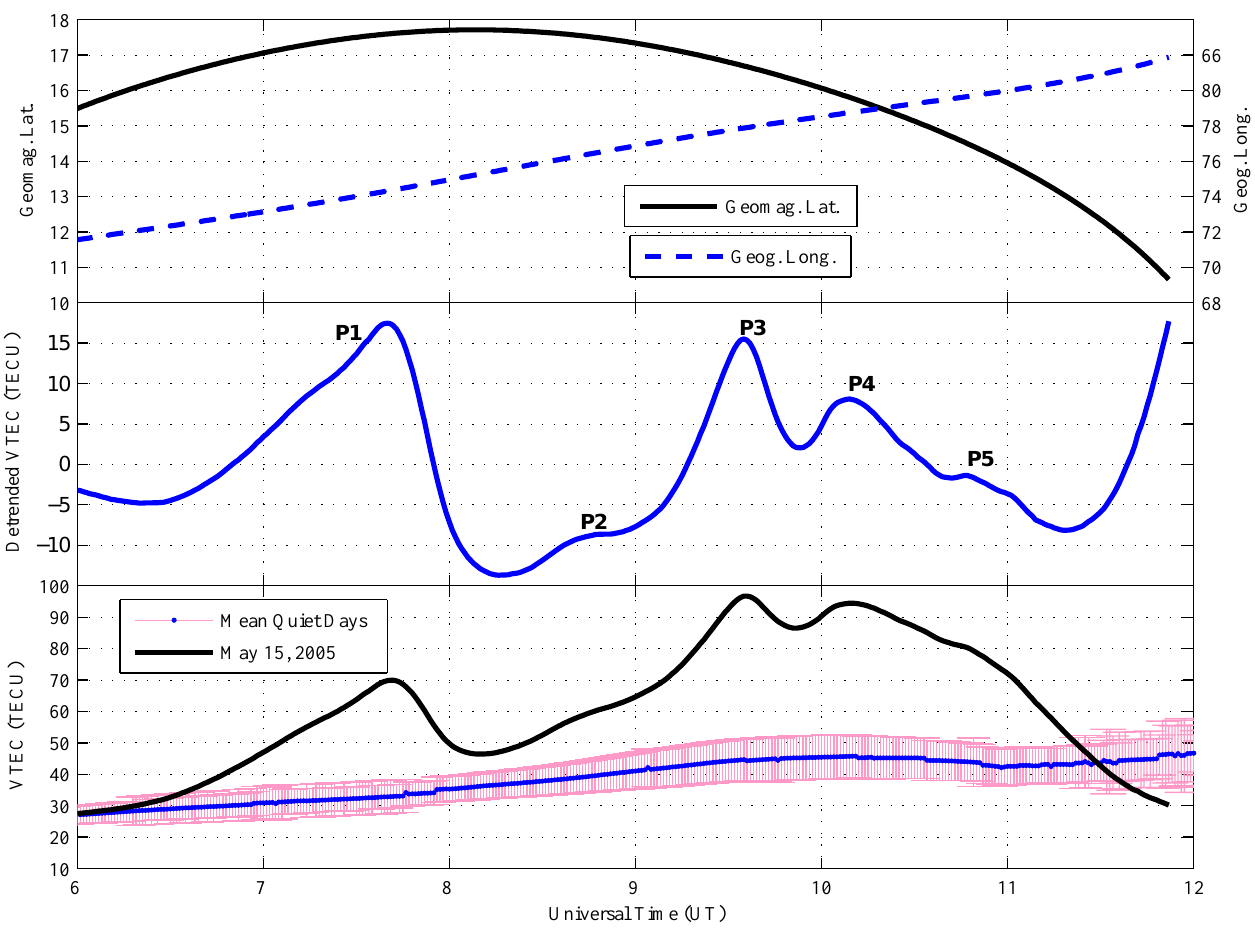
Fig. 3b. VTEC observations from Udaipur for PRNs 22. Rest is same as Fig. 3a. show large differences between the mean VTEC curves and the VTEC curves of 15 May for both the PRNs 14 and 22.